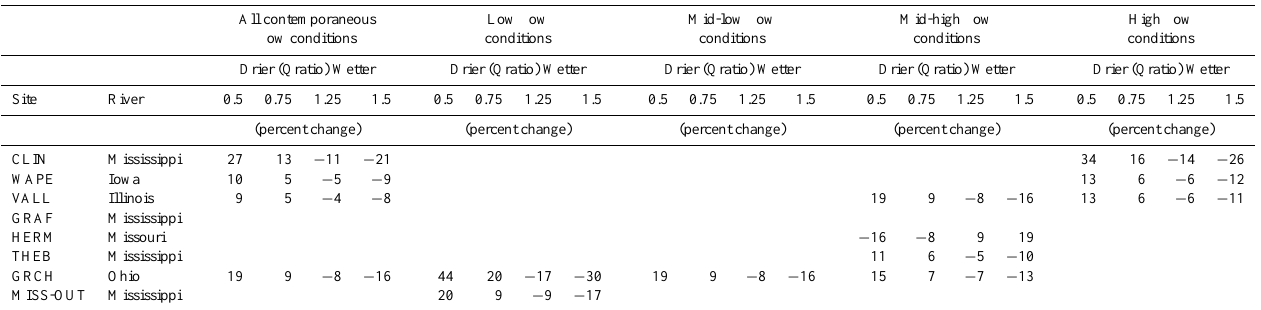
Table 4. Percent difference in nitrate concentration relative to nitrate concentration expected following a year with average flow conditions (see Eq. 5). Positive and negative percent differences describe the increase or decrease of nitrate concentration, respectively, in response to four hypothetical antecedent flow conditions. Qratio scenarios describe when mean daily streamflow the previous year was 50 and 25 percent lower than average (Qratios 0.50 and 0.75, respectively) and 25 and 50 percent higher than average (Qratios 1.25 and 1.50, respectively). These scenarios are only applied to relationships that were statistically significant ( p < =